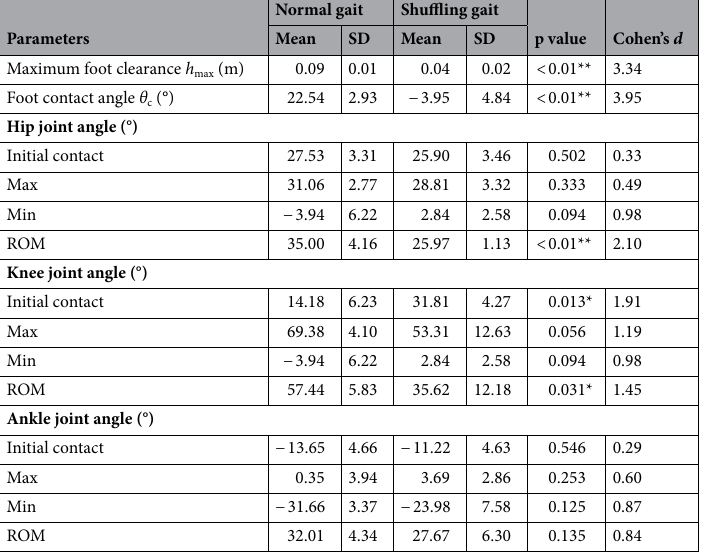
Table 1. Mean and SD values for maximum foot clearance, foot–floor angle at initial foot contact, and lower- limb joint kinematics parameters. * p < 0.05. ** p < 0.01.